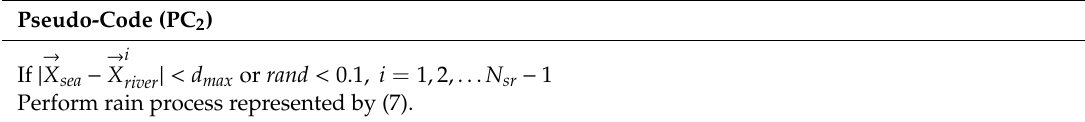
Table 3. Pseudo-code of the evaporation of the seawater.